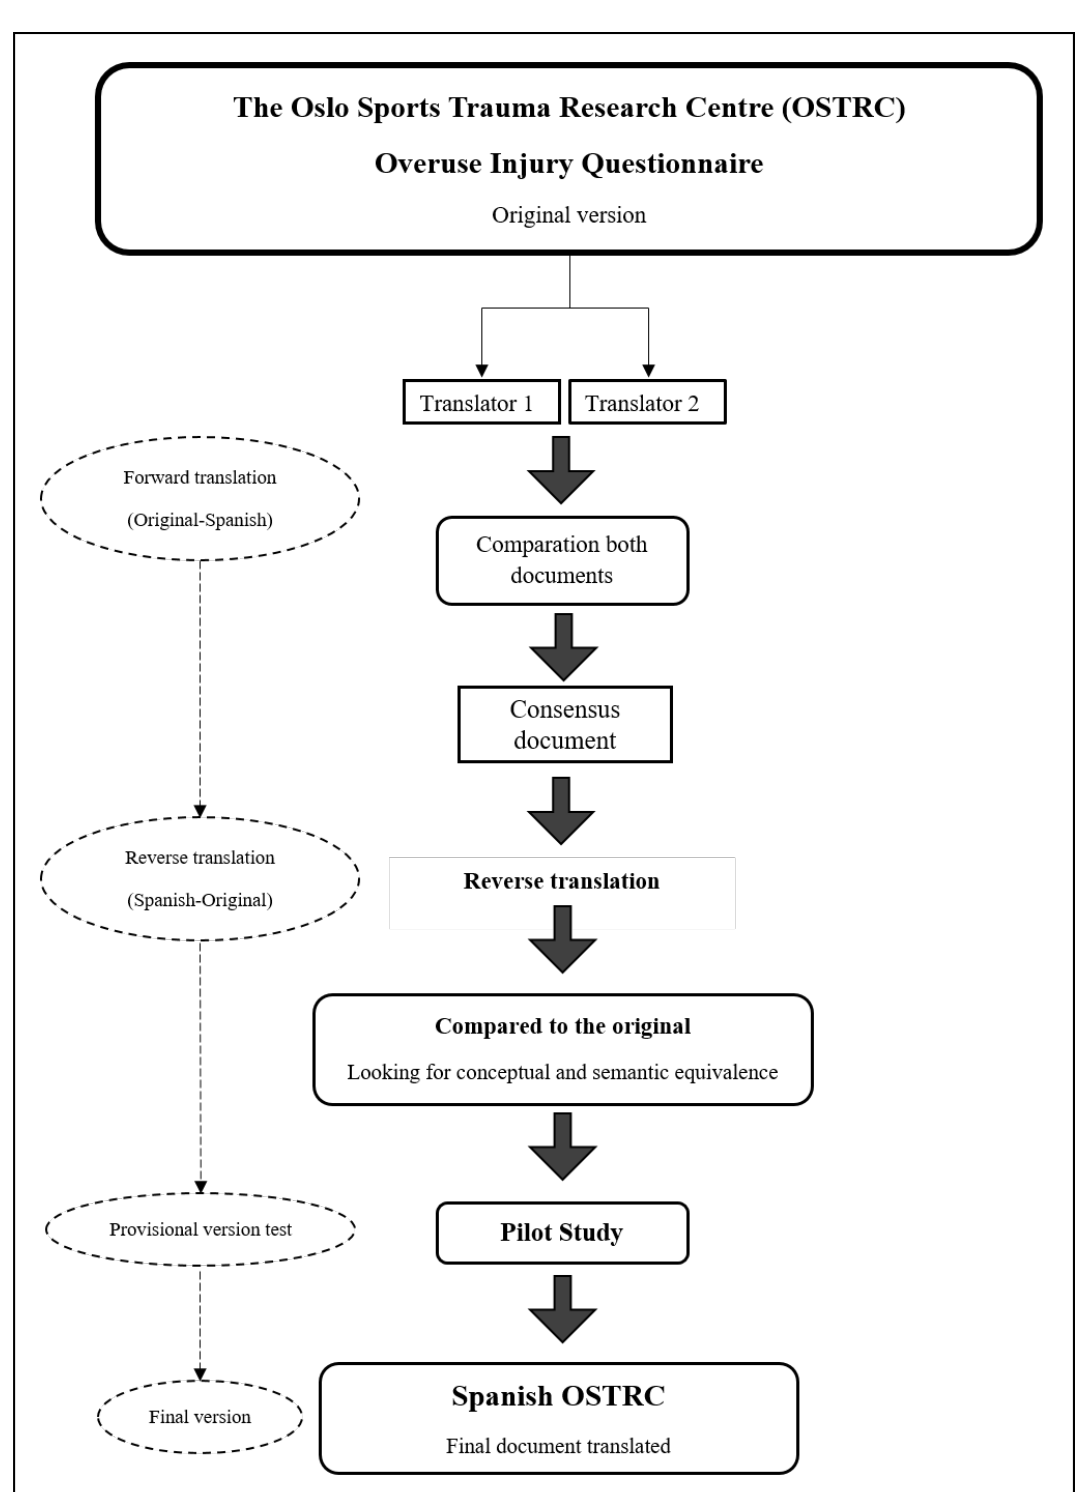
Figure 1. Flowchart of the development process of the OSTRC Spanish version.